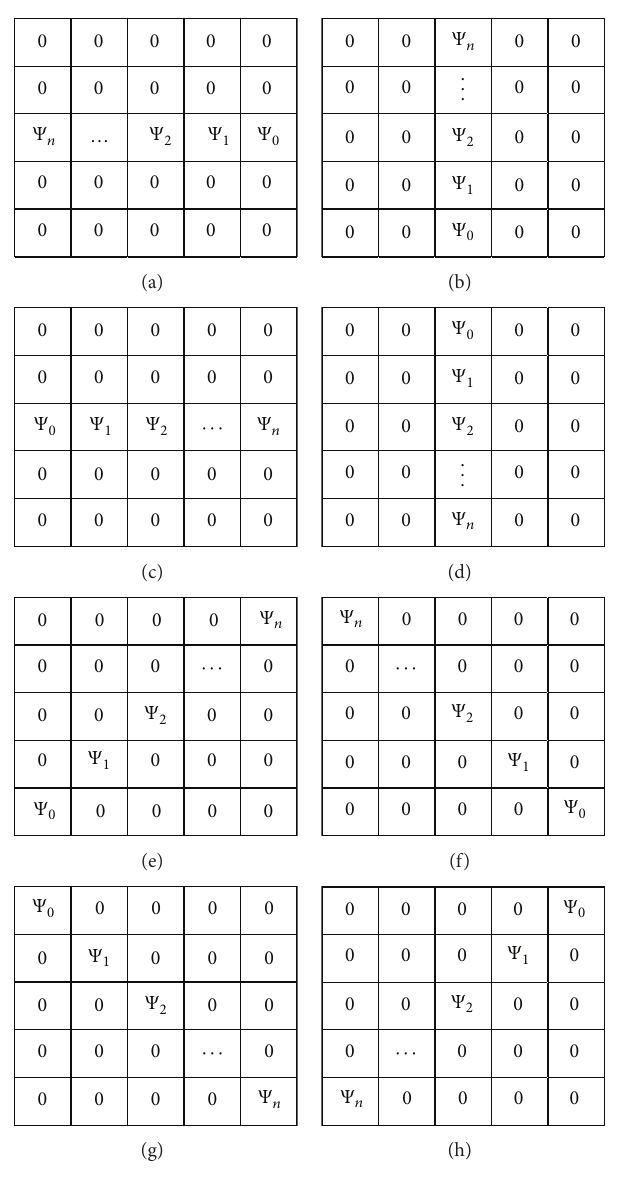
Figure 1: Fractional heat masks on eight directions: 0 ∘ , 45 ∘ , 90 ∘ , 135 ∘ , 180 ∘ , 225 ∘ , 270 ∘ , and 315 ∘